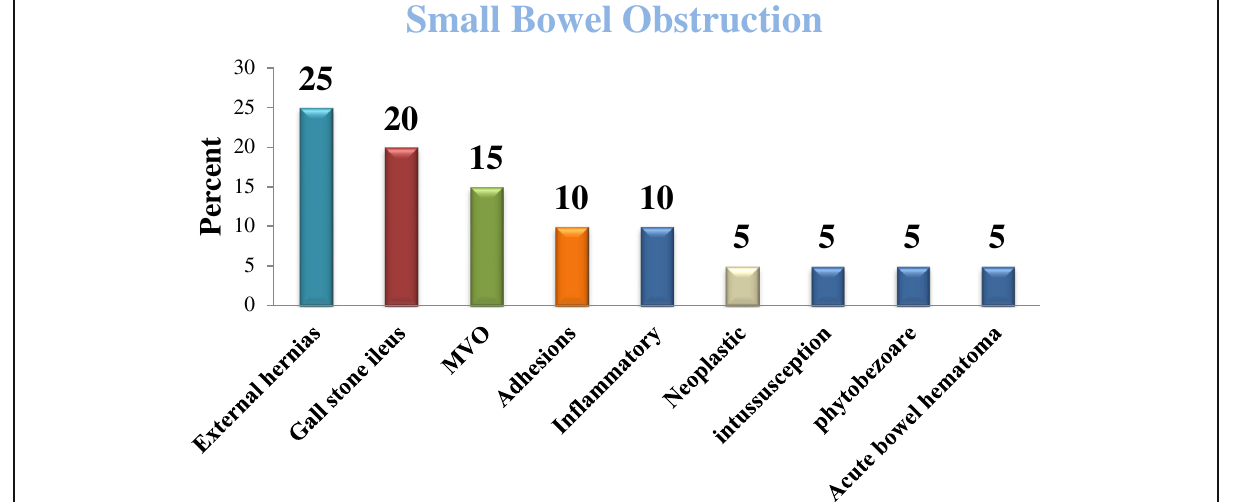
Fig. 3 Distribution of patients according to the causes of small bowel obstruction